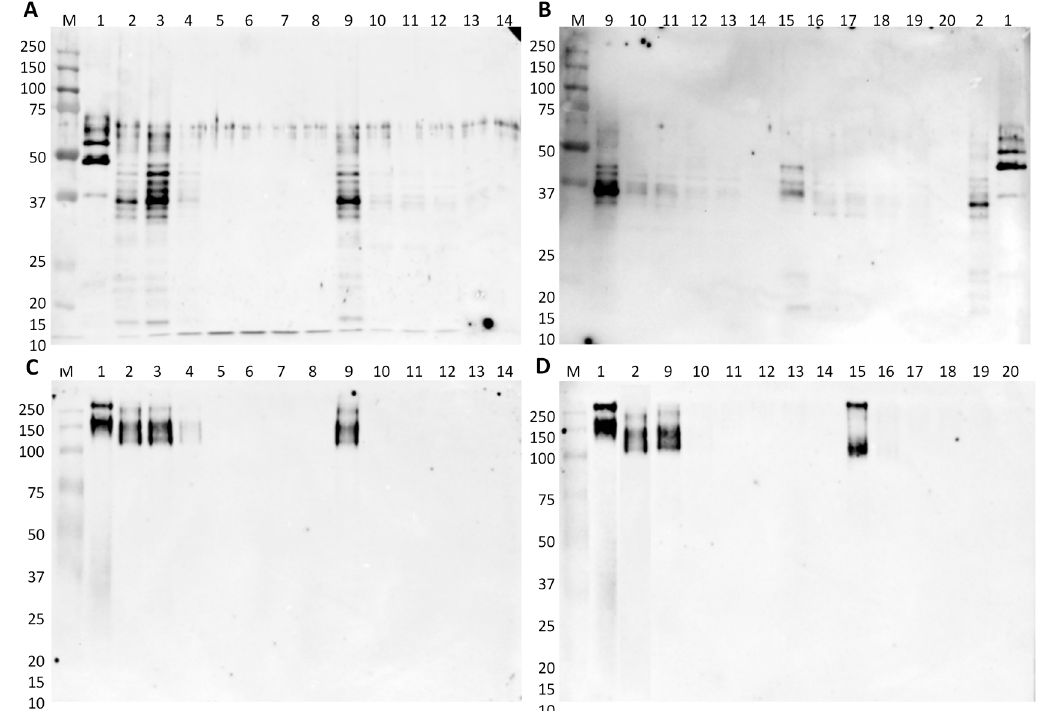
Figure 2. Immunoblot membranes for lupine testing using anti-gamma-conglutin polyclonal antibody in denaturing ( A , B ) and native conditions ( C , D ) comparing rice and wheat flours model mixtures ( A , C ) and wheat flour with model breads ( B , D ). Legend: lane 1, L. luteus ; lane 2, L. albus ; lanes 3–7, 10%, 1%, 0.1%, 0.01%, and 0.001% of L. albus in rice flour; lane 8, rice flour (0% lupine flour); lanes 9–13, 10%, 1%, 0.1%, 0.01%, and 0.001% of L. albus in wheat flour; lane 14, wheat flour (0% lupine flour); lanes 15–19, 10%, 1%, 0.1%, 0.01%, and 0.001% of L. albus in bread; lane 20, wheat bread (0% lupine flour); lane M, Precision Plus Protein Dual Color Standard 10–250 kDa.